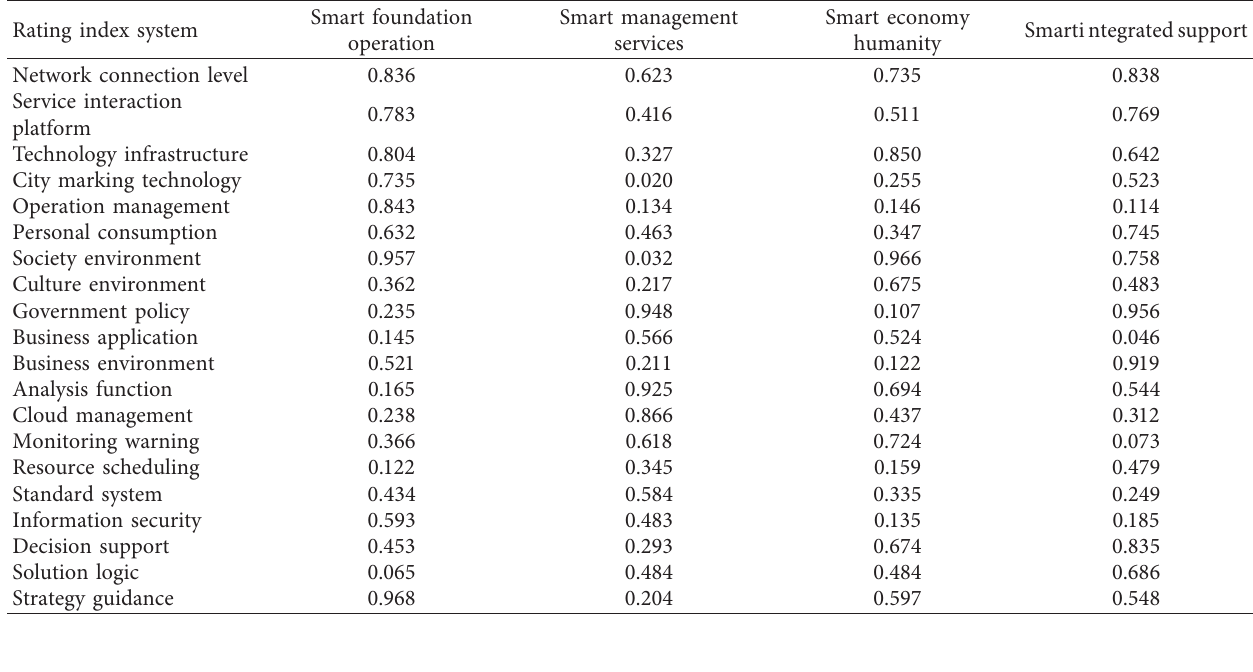
Table 1: Rating system of smart city resource scheduling based on digital